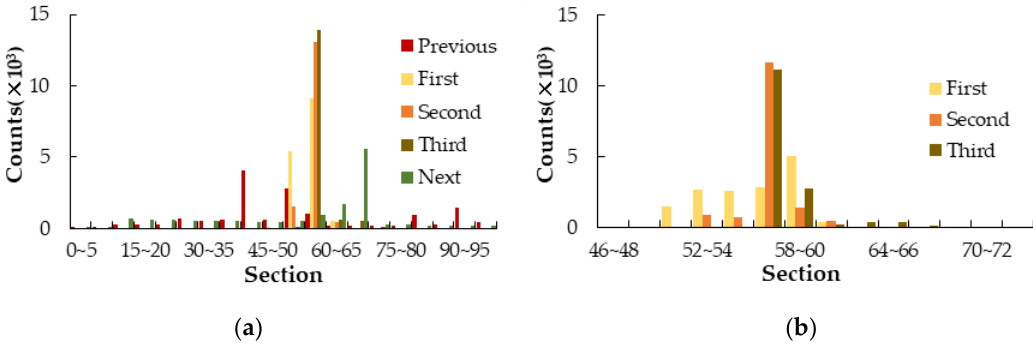
Figure 13. Distribution of estimated values of continuous missing pixels: ( a ) compare the continuous missing data with the data before and after ( b ) comparison between consecutive missing data.